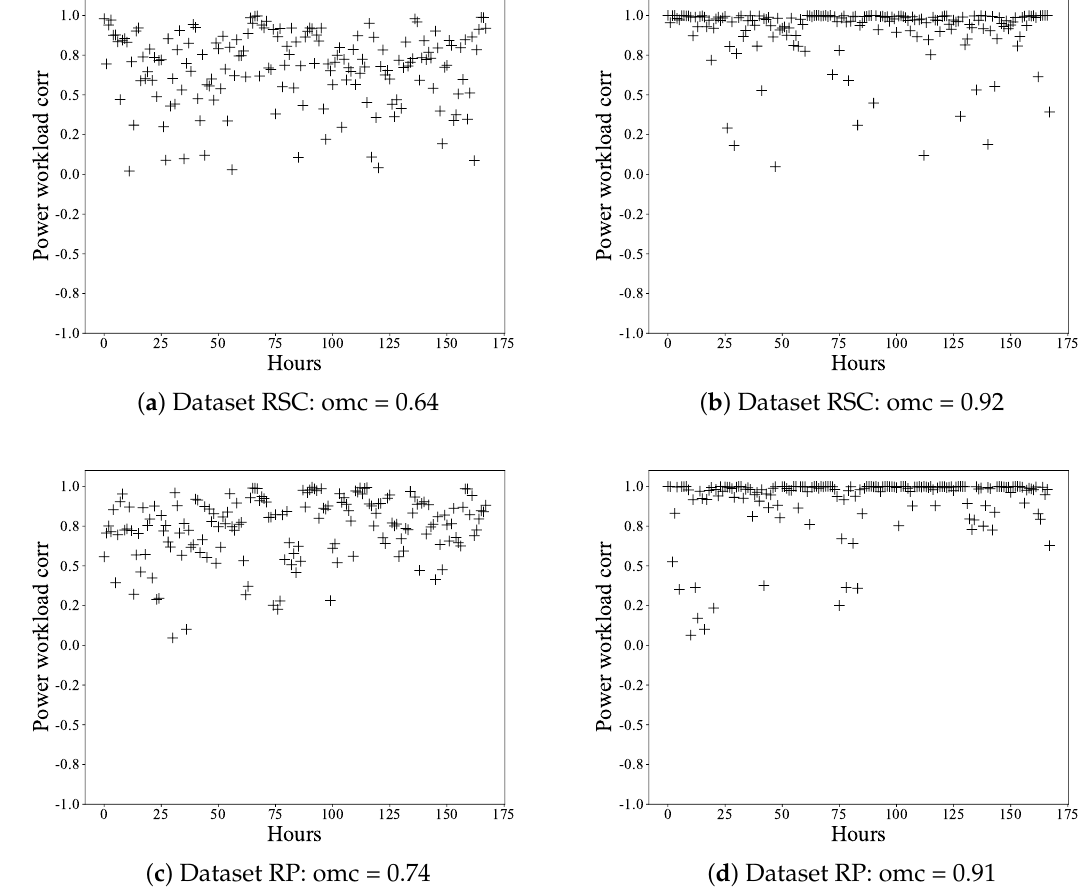
Figure 8. The correlations before and after noise reduction. omc, overall mean